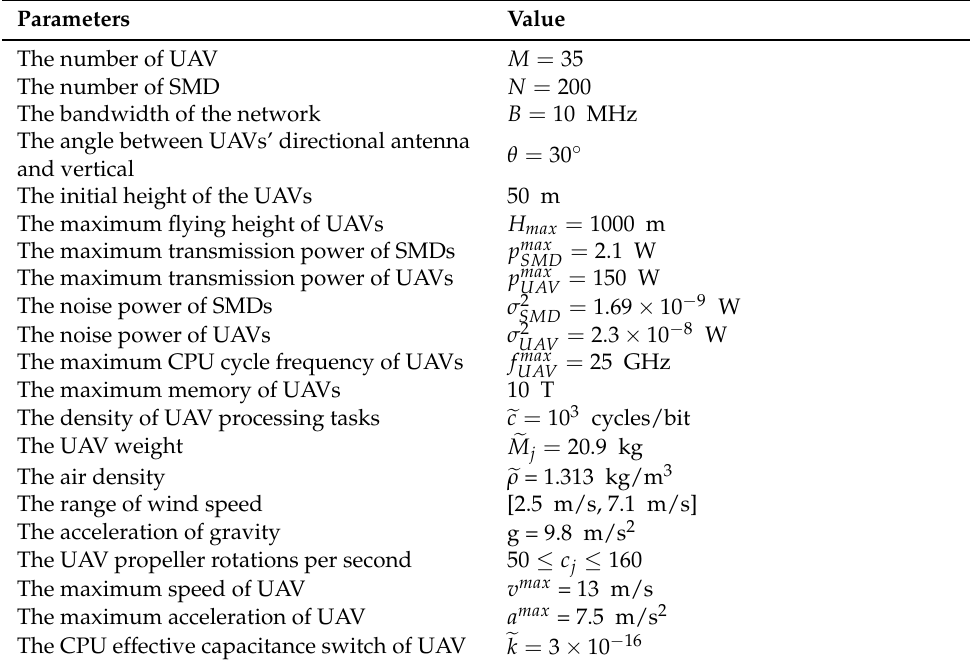
Table 2. Definition of the main experimental